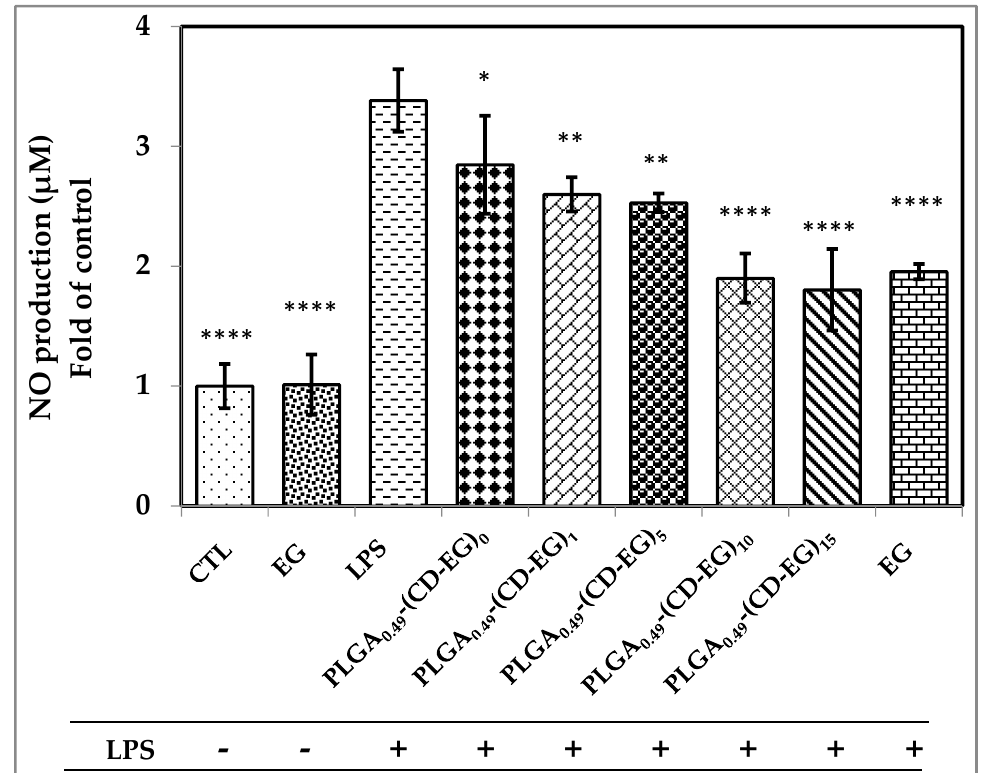
Figure 7. Effects of PLGA 0.49 -(CD-EG) formulations on NO production by BV-2 microglial cells in the presence or absence of 50 ng/mL of LPS by Griess reagent method. CTL is the control without the addition of EG and LPS. As compared to LPS, the marks of statistical significant *, **, *** and **** represent p < 0.05, 0.01, 0.001, and 0.0001, respectively.